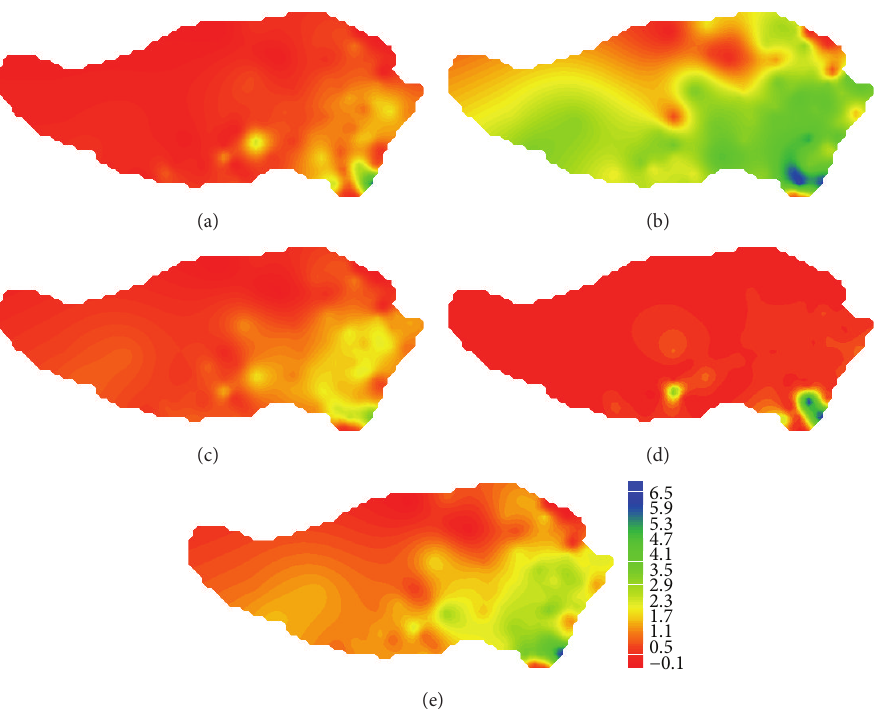
Figure 8: Observed values of precipitation on the Tibetan Plateau in reference period: (a) spring; (b) summer; (c) fall; (d) winter; (e) annual.